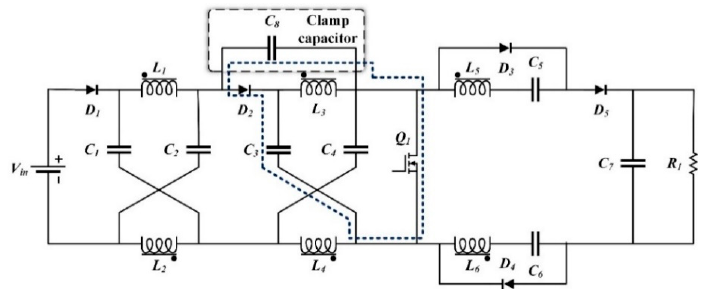
Figure 1. Two cascaded Z-source high step-up converter.